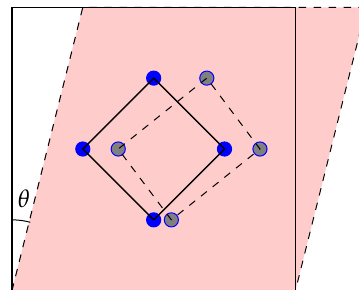
Figure 1. Illustration of the distortion of tetrahedral → tetrahedral paths under shear deformation. The undeformed path becomes stretched along two directions and compressed along the other two. θ represents the shear angle (refer to Section